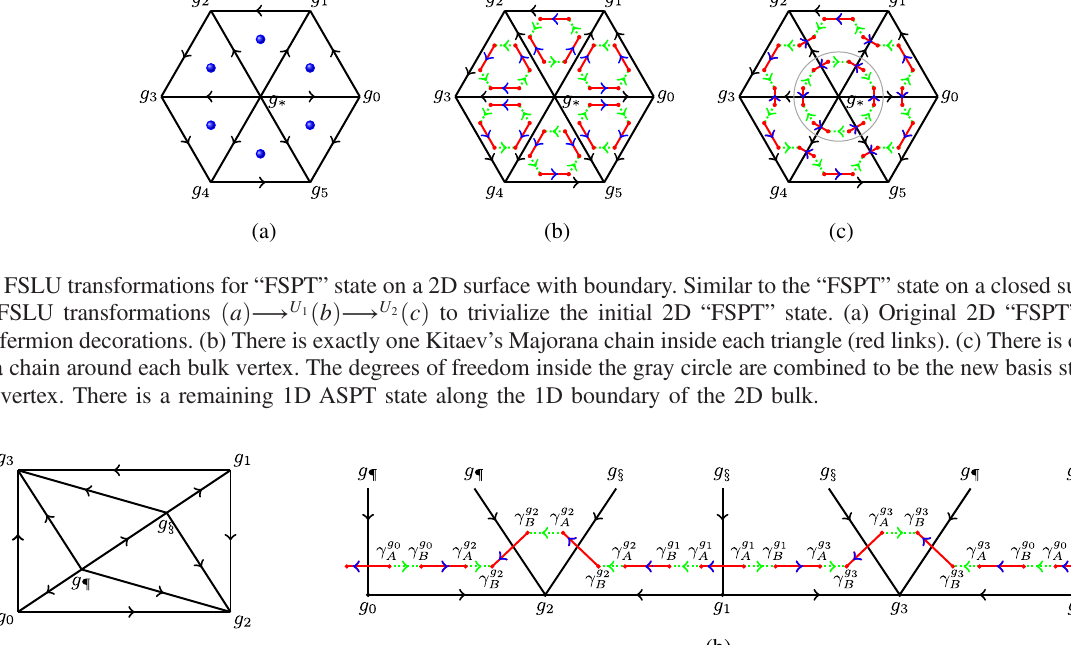
FIG. 6. ASPT on the 1D boundary of 2D bulk. On the boundary, the Majorana fermions forming a nontrivial Kitaev chain (red dots) are labeled by A=B and g ∈ G . The blue arrow indicates that the pairing directions may be changed under symmetry action. (a) 2D bulk b (b) 1D